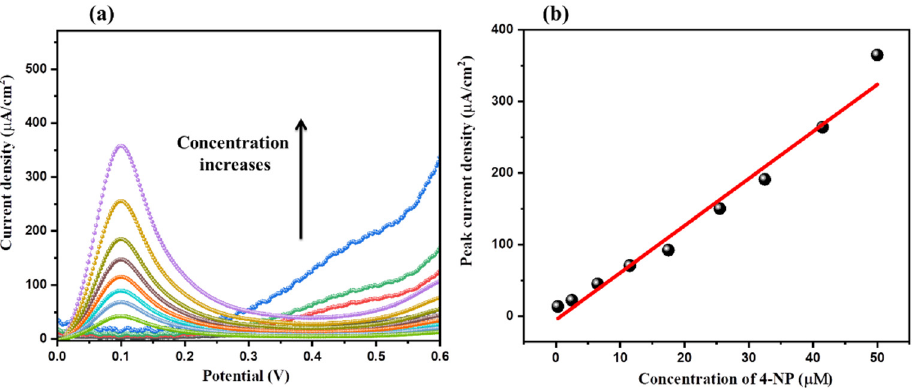
Figure 7. LSV ( a ) of MnO 2 /rGO/GCE in various concentrations (0, 0.3 µM, 2.5 µM, 6.5 µM, 11.5 µM, 17.5 µM, 25.5 µM, 32.5 µM, 41.5 µM and 50 µM) of 4-NP (scan rate = 50 mV/s). The calibration curve ( b ) of the peak current density versus the concentration of 4-NP.